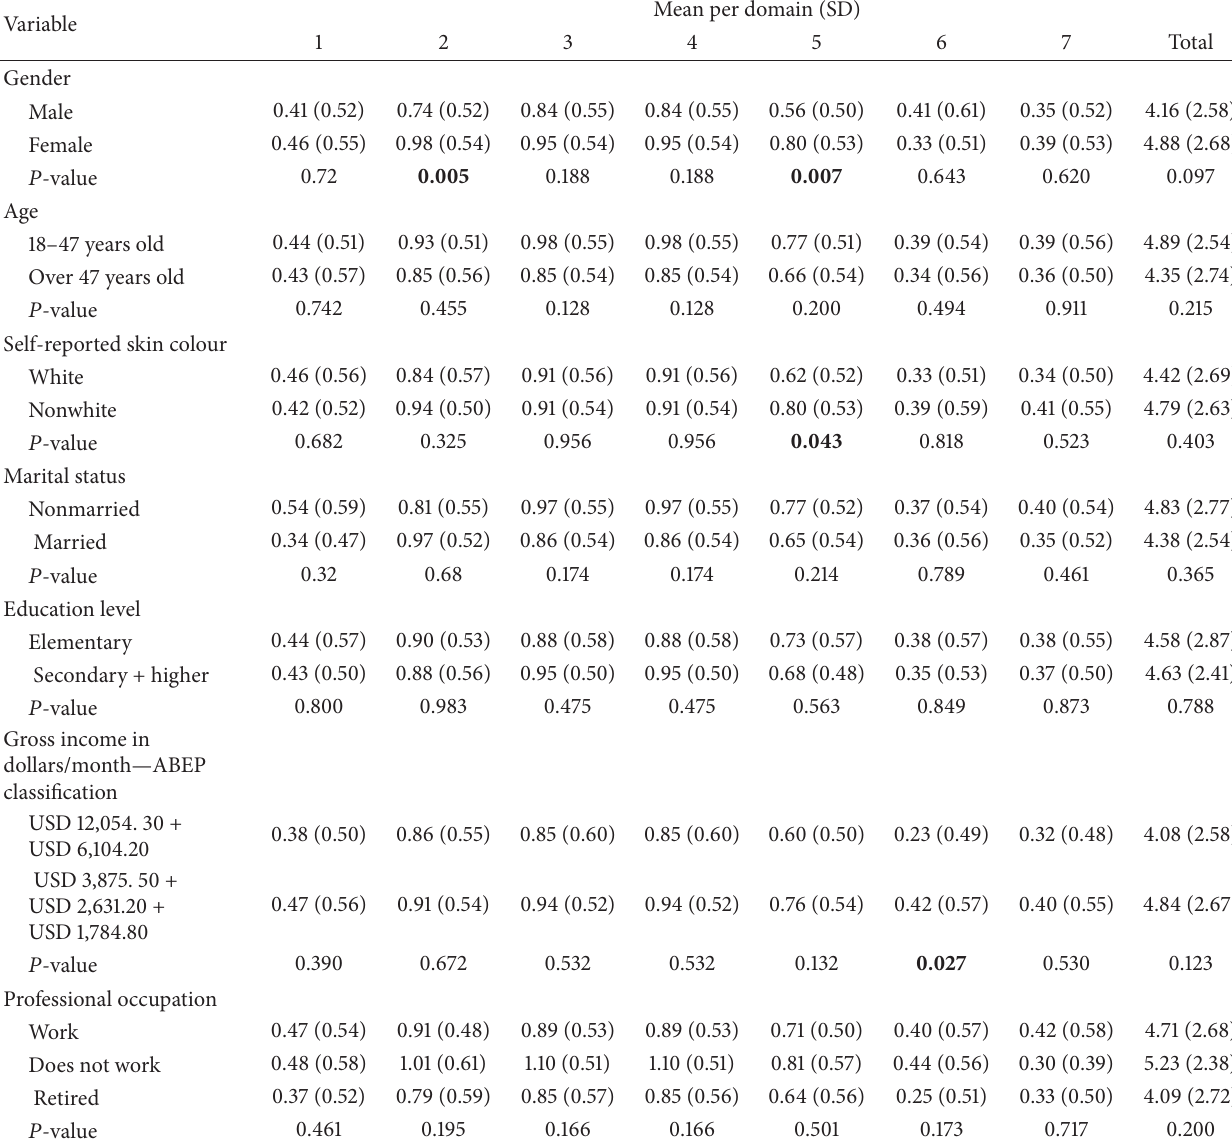
Table 2: Mean, standard deviation, and 𝑃 -value (Mann-Whitney and Kruskal-Wallis) of socioeconomic and demographic variables per domain and overall OHIP-14 of patients treated in the Periodontics section, Dental Specialty Centres (Centros de Especialidades Odontol´ogicas), Juiz de Fora,